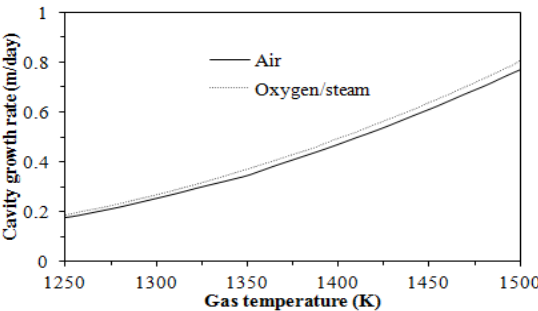
Figure 44. Cavity growth rate, as a function of gas temperature, for two different bulk gas compositions [80].